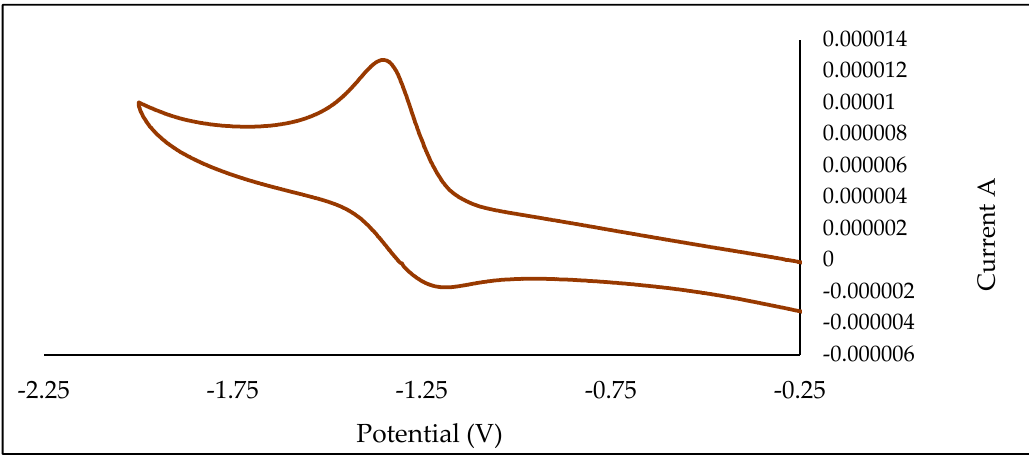
Figure 2. Representative cyclic voltammogram of second-generation D6 , in 0.1 M Bu 4 NPF 6 in propylene carbonate, scan rate = 0. 2 V/s, at − 15 °C. Table 1. Redox activity of dendrimers 1–12 at 0 °C.